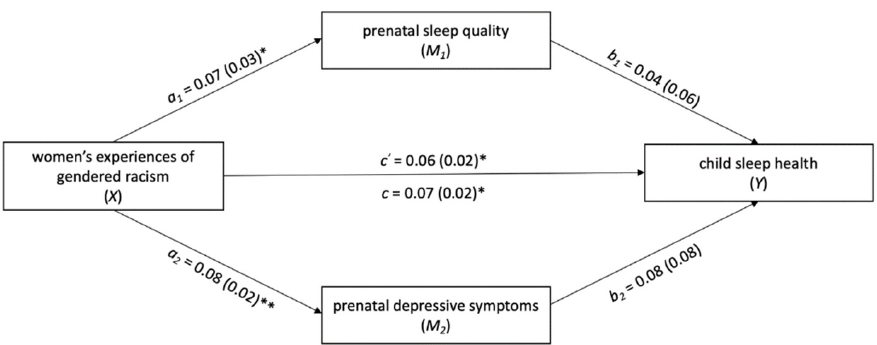
Figure 2. Examining prenatal sleep quality and depressive symptoms as parallel mediators of the association between women’s experience of gendered racial stress and child sleep health at age two. Note. ** p < 0.01, * p < 0.05. Statistics displayed are unstandardized regression coefficients with standard errors in parentheses. The following covariates were included in the above mediation model: maternal age, SES, prenatal substance use, child age, number of people in the home at child age two, and maternal depressive symptoms at child age two. C (cid:48) represents the direct effect of X on Y, or the effect of X on Y while M 1 and M 2 are held constant. C represents the total effect of X on Y, which is the sum of the direct and indirect effects of X on Y. Indirect effects (A 1 *B 1 and A 2 *B 2 ) are described